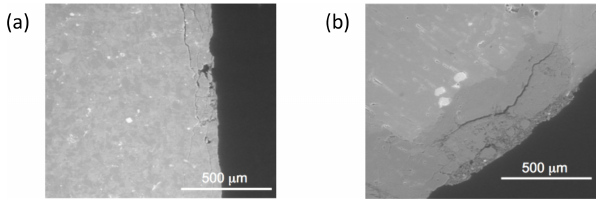
Figure 2. Scanning electron microscope images depicting subsur- face lateral cracks, formed after repeated binary collisions of rocks at energies representative of bed-load transport. We speculate that these cracks, and the shattered region bounded by them, are the re- sult of compressive fracture cones formed by impulsive collisions. Images show thin sections of (a) quartz diorite and (b) volcanoclas- tic rock. Figure reproduced from Miller and Jerolmack